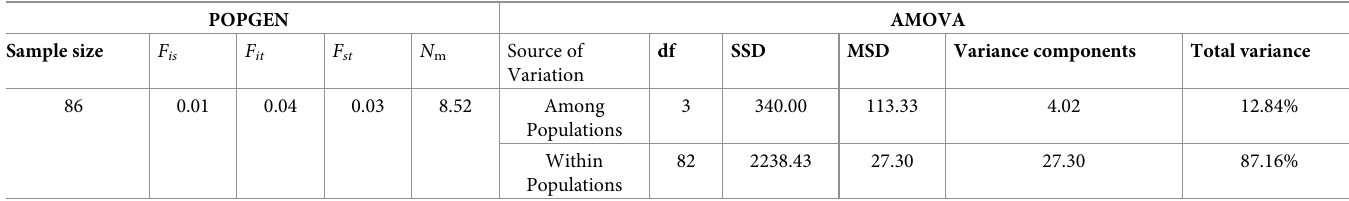
Table 4. Genetic differentiation of tea populations along the altitude gradient. POPGEN